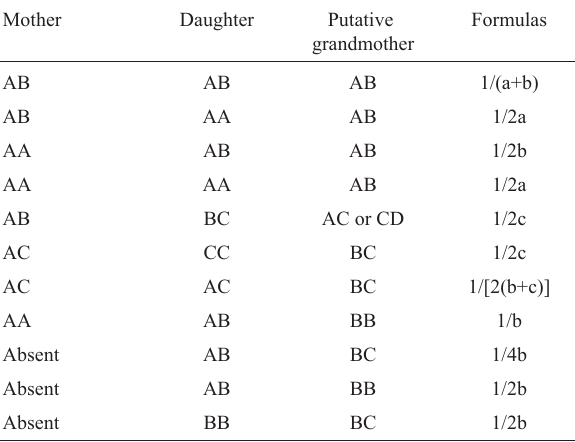
Table 2 - Formulae used to calculate PI considering the profile configura- tions depicted with ChrX STRs, in cases 1 and 2.